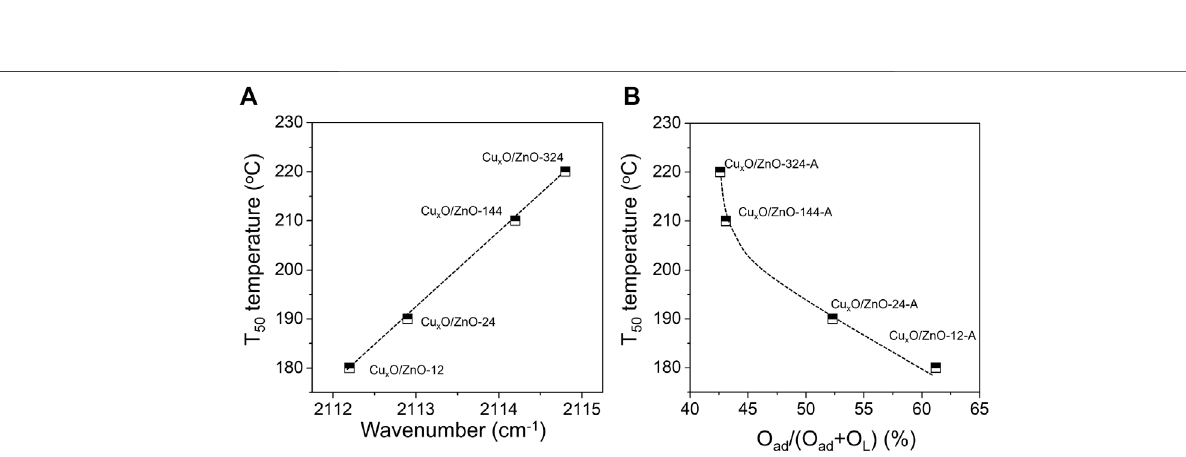
(B) : Spectroscopic data between 2060 and 2160 cm − 1 . x O/ZnO catalyst.